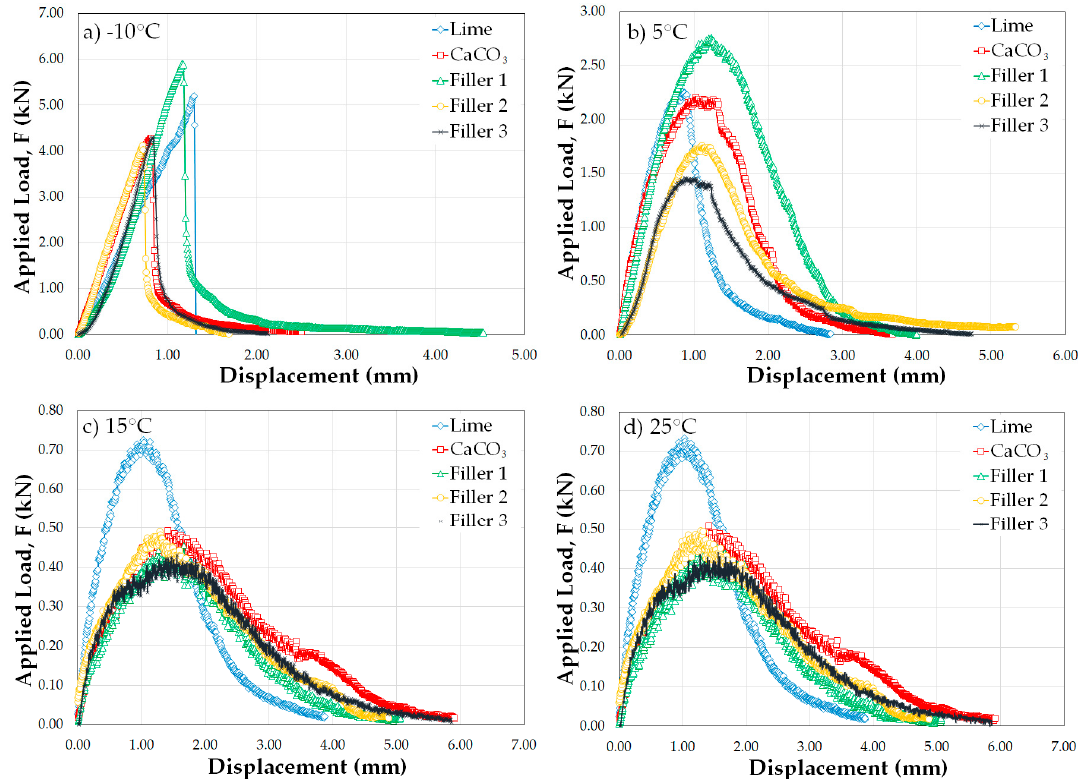
Figure 7. Semicircular bend load–displacement graph of all fillers at ( a ) − 10 °C; ( b ) 5 °C; ( c ) 15 °C and ( d ) 25 °C.